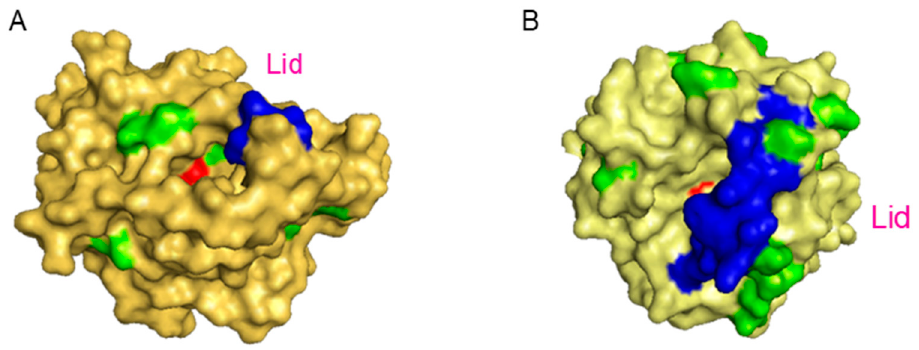
Figure 2. Hydrophobic area and Lid of ( A ) CAL-B, ( B ) TLL. Lid ( blue ) and Hydrophobic area ( green ).